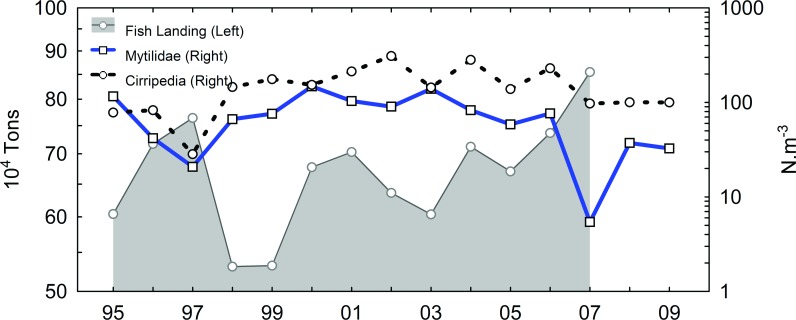
Annual average of barnacle nauplii (Cirripedia; black dotted line) and mussel larvae (Mytilidae; blue continuous line) superimposed on total fish catch (grey area).Fishery data derived from [32,33].